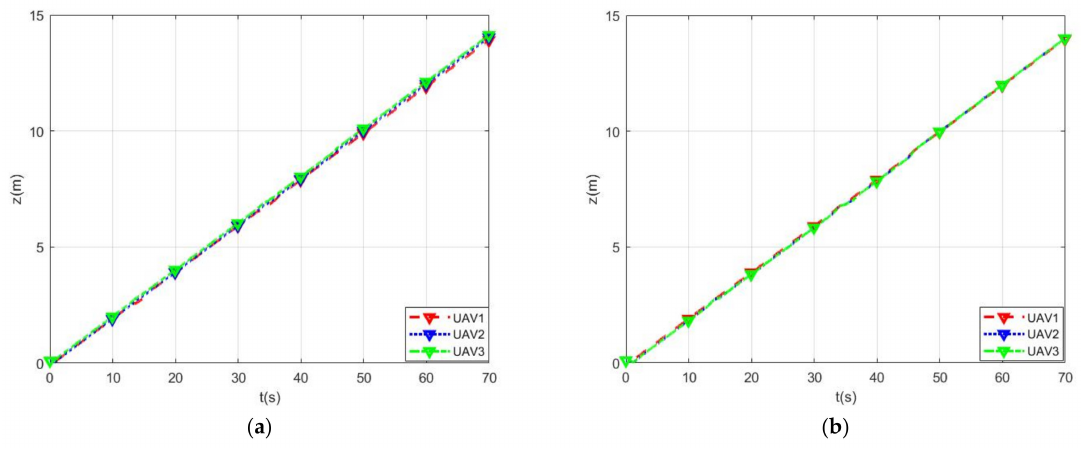
Figure 14. Trajectory tracking with RMPC ( a ) and IMPC ( b ) in the z -axis direction in Case 2. The UAVs in the formations with IMPC and RMPC are able to maintain their relative distance from the z